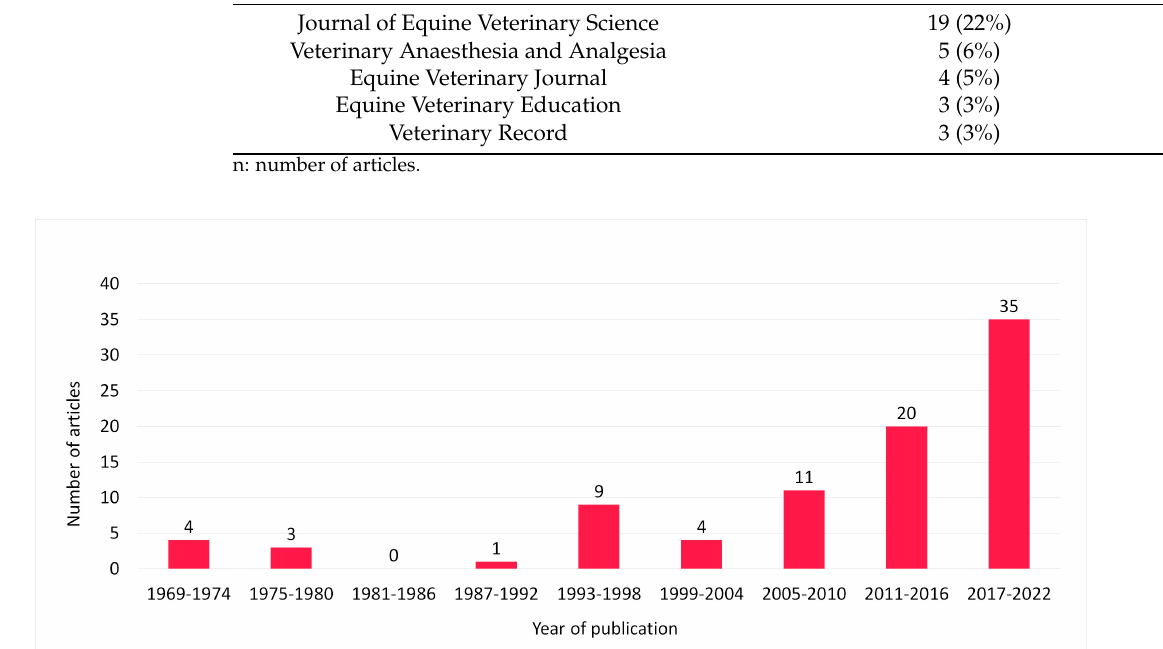
Table 2. Top journal publishing three or more articles on the topic of interest of this review (n = 87).